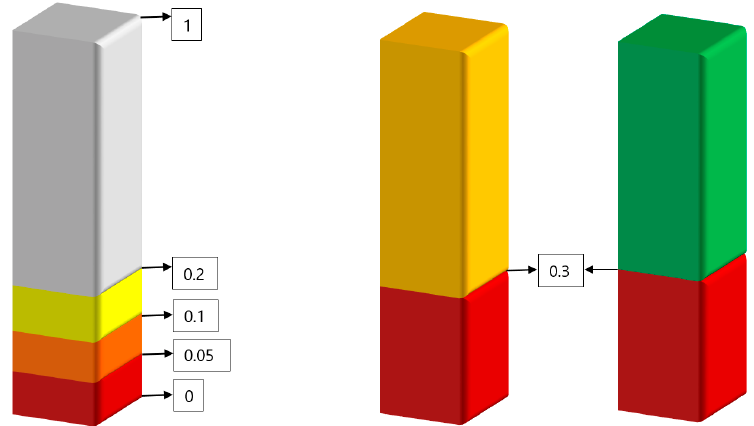
Figure 10. Demonstration of the developed rectangular gauge on a 0–1 scale for underload situation management (left), and combination of operator loads for underload situation management (right).